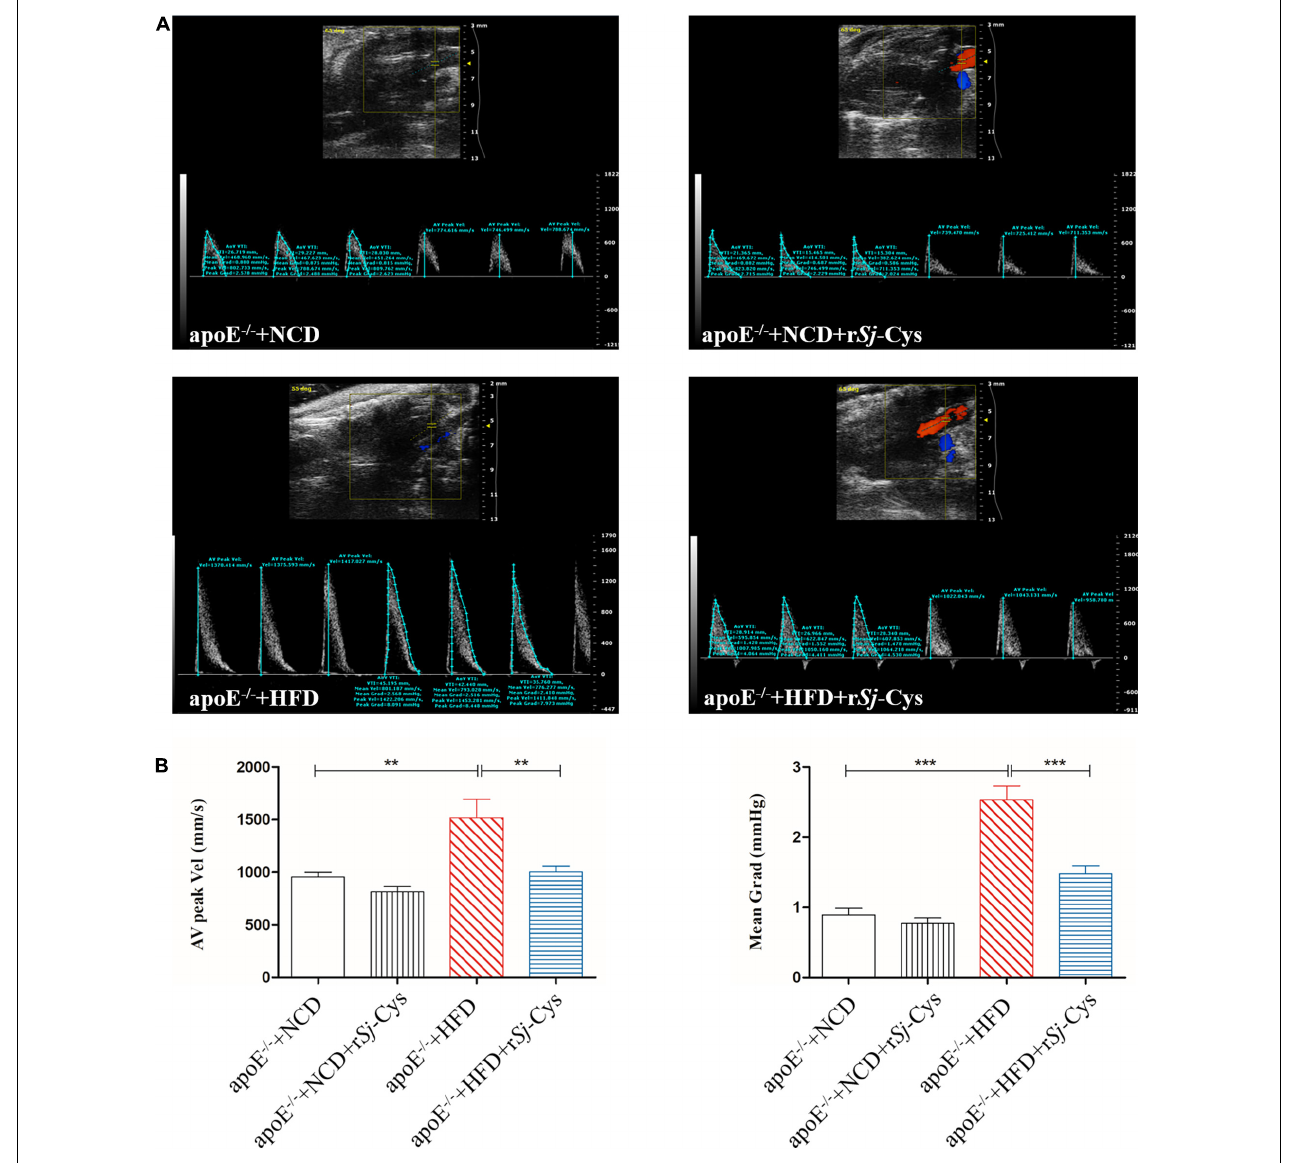
FIGURE 4 | Treatment of r Sj -Cys improved hemodynamic function. (A) Representative color Doppler ultrasound of the heart. (B) r Sj -Cys improves the AV peak velocity and mean gradient of the ascending aorta. The data are shown as the mean ± SEM for each group ( n = 6 per group). ** P < 0.01, *** P <